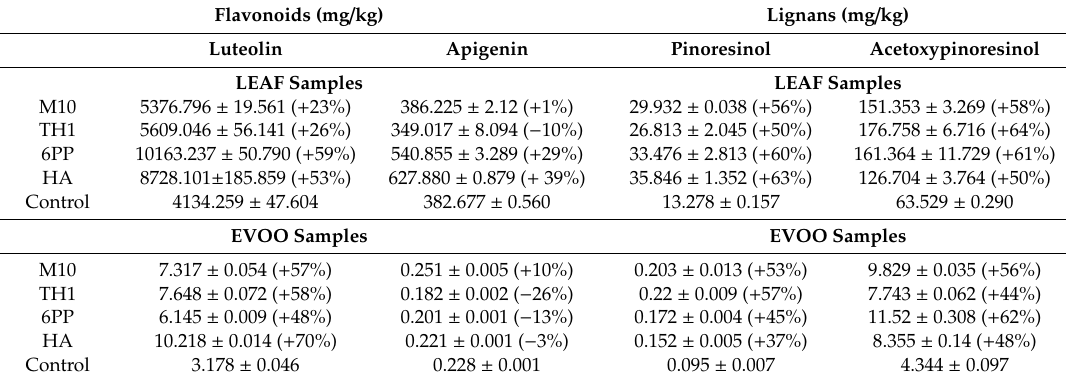
Table 3. Flavonoids and lignans in leaf and extra-virgin olive oil (EVOO) samples.